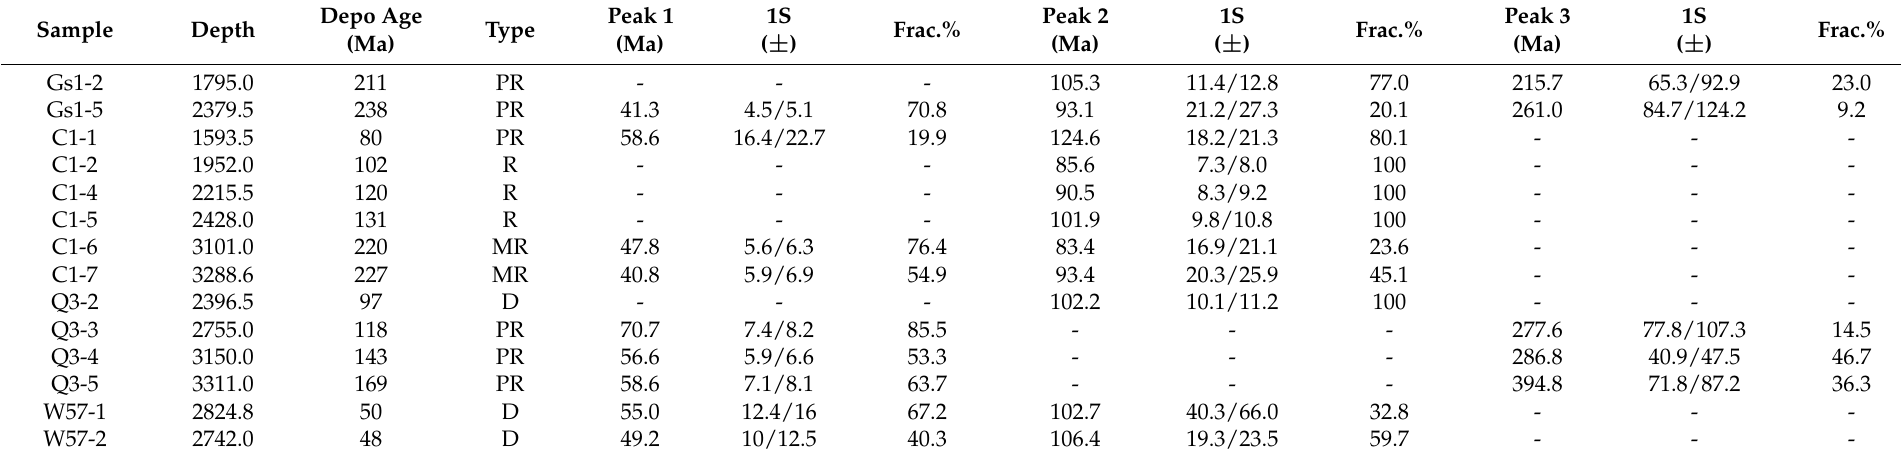
Table 2. Apatite fission-track age